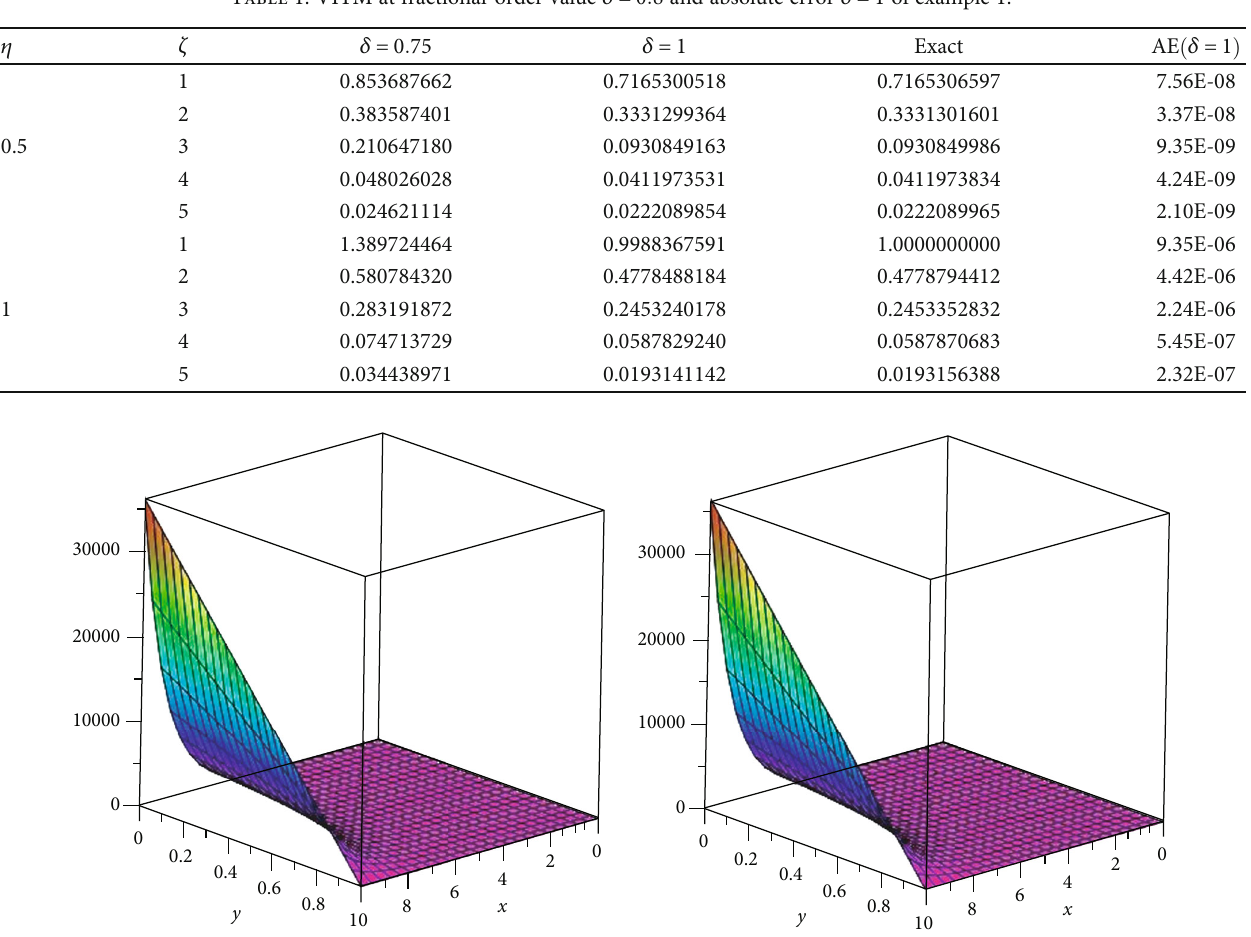
Figure 3: Graph of exact and approximate solutions of Problem